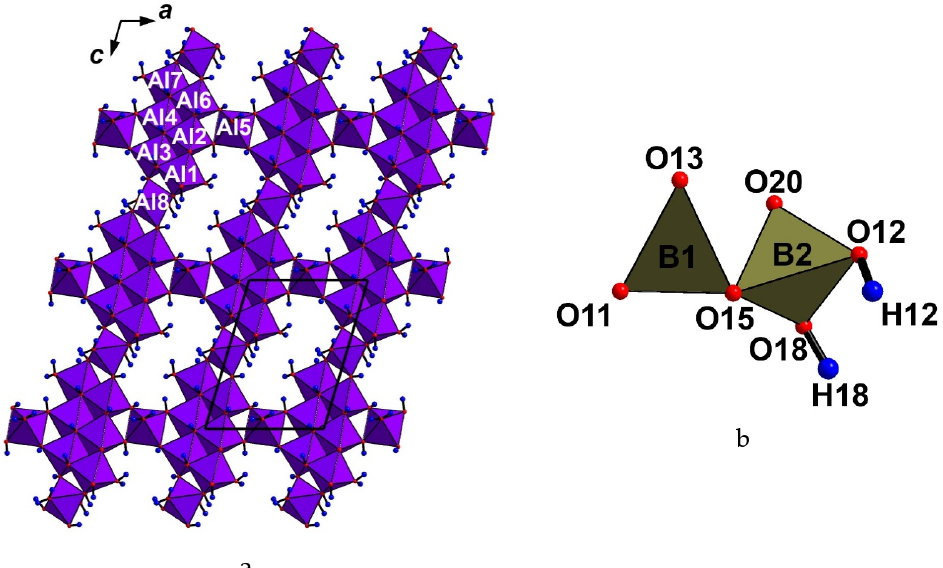
a Figure 3. Octahedral layer ( a ) and insular [B 2 O 4 (OH) 2 ] 4 − group ( b ) in the structure of krasnoshteinite. Figure 3. Octahedral layer ( a ) and insular [B 2 O 4 (OH) 2 ] 4- group ( b ) in the structure of For legend, see Table krasnoshteinite. For legend, see Table 3.